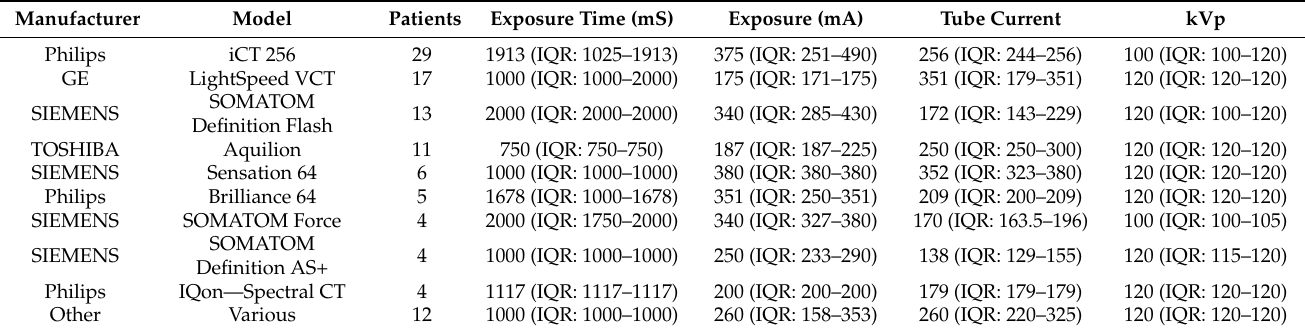
Figure A1. ( A ) Flowchart showing the exclusion criteria used for the HERMES dataset. Exclusion criteria were: No FU-NCCT available, which was acquired between 12 h and 2 weeks ( n = 637), an intracranial region segmentation error ( n = 3), and a registration error ( n = 7). In total, 1018 patients were included. These were split into a training set ( n = 876), a validation set ( n = 50), and a testing set ( n = 101). ( B ) Flowchart showing the exclusion criteria used for the BASICS dataset. Exclusion criteria were: No FU-NCCT available ( n = 55) or an image quality that was too low ( n = 6). In total, 107 patients were included. These were split into five training and testing sets for the five-fold cross-validation. Patients could only belong to one test set. Table A1. Imaging parameters used to acquire the NCCT scans of the included patients from the BASICS trial. Imaging parameters were missing for two